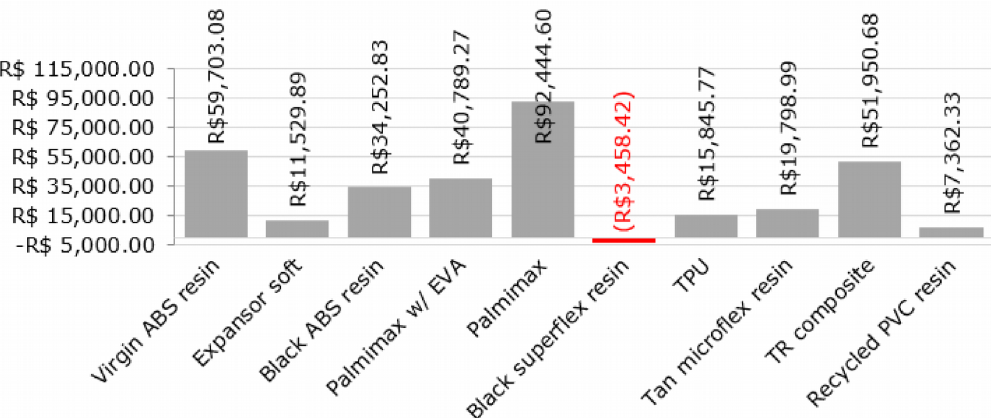
Figure 8. Class A inventory